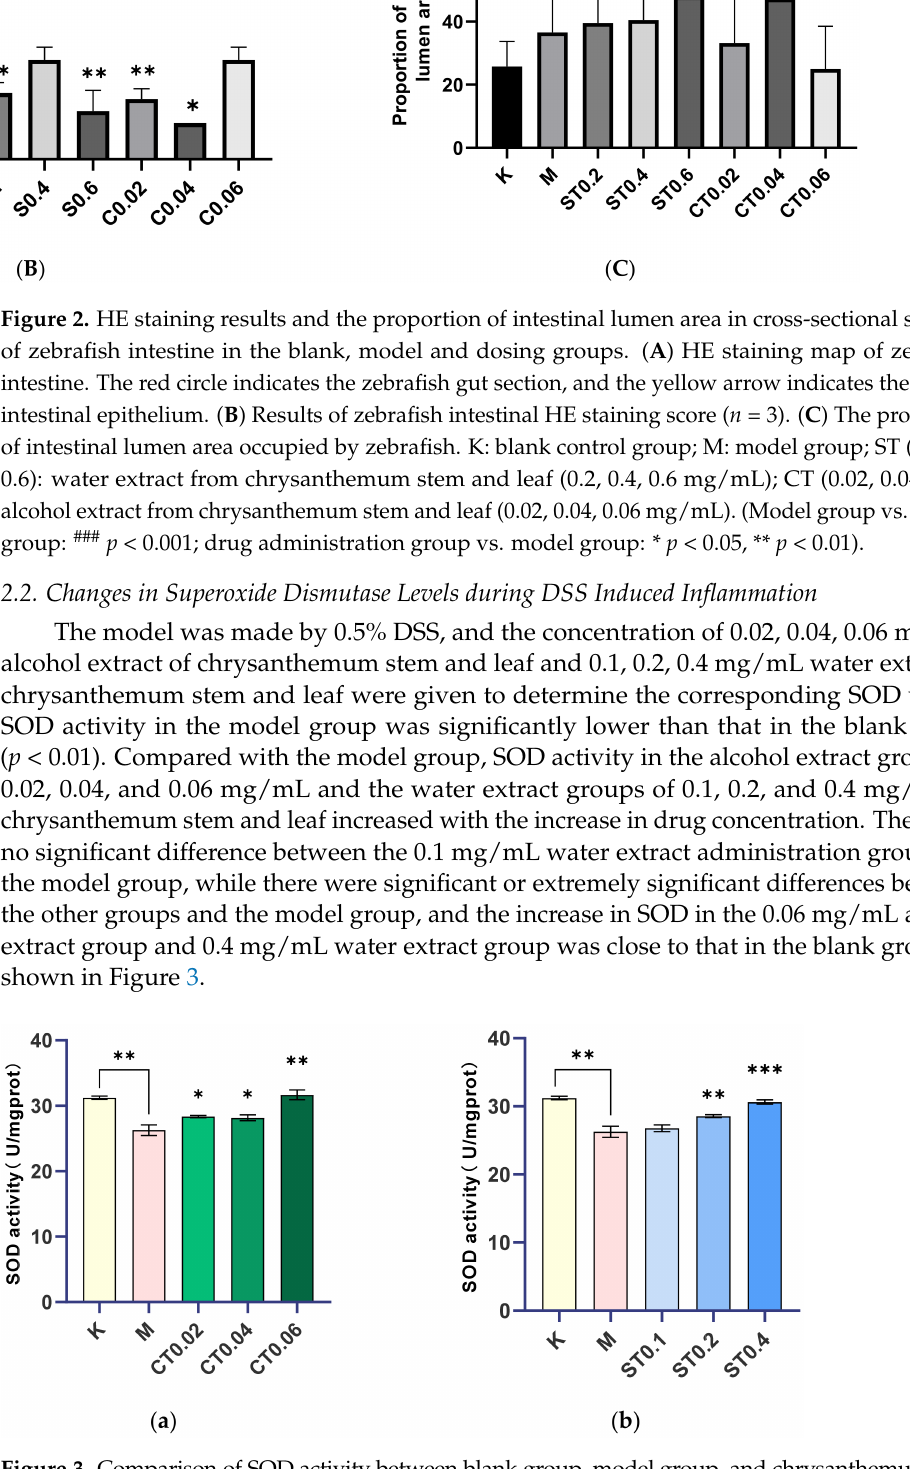
Figure 3. Comparison of SOD activity between blank group, model group, and chrysanthemum stem and leaf administration group. ( a ) Changes of SOD activity after modeling and alcohol extract of chrysan- themum stem and leaf were administered. ( b ) Changes of SOD activity after modeling and